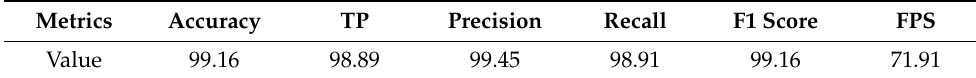
Table 5. Performance Metrics of the Proposed Methodology.